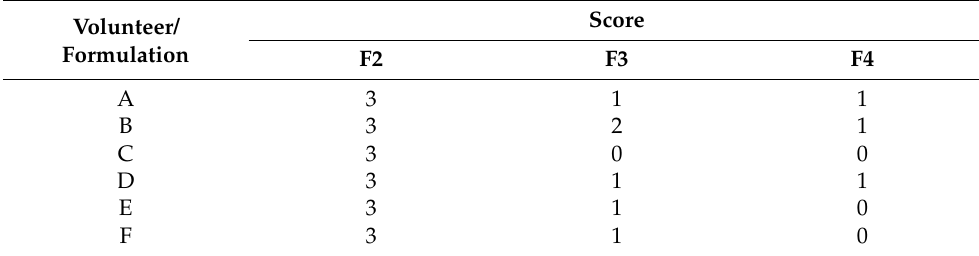
Table 5. Sensory evaluation of designed ODFs: 0—no bitterness, 1—slight bitterness, 2—moderate bitterness, 3—significant